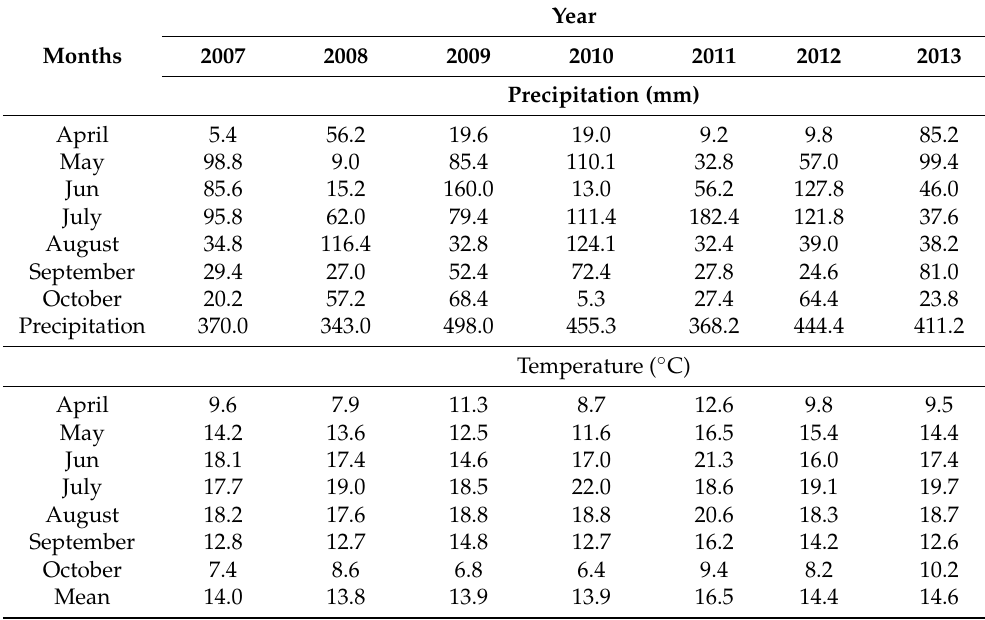
Table 1. Weather Conditions in the Vegetation Period